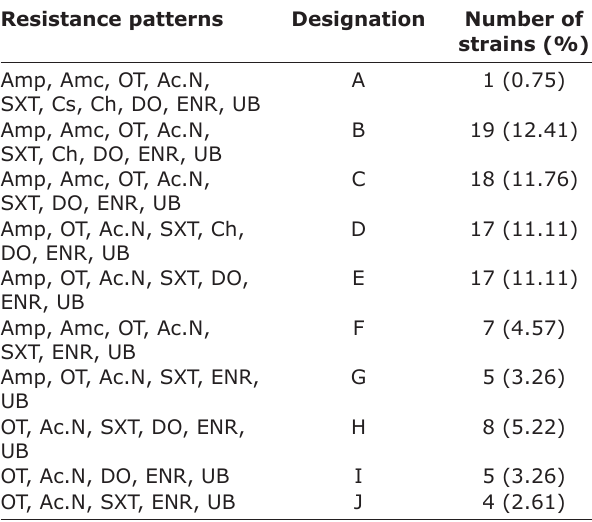
Table-3: The most frequent antibiotic resistance patterns of Escherichia coli